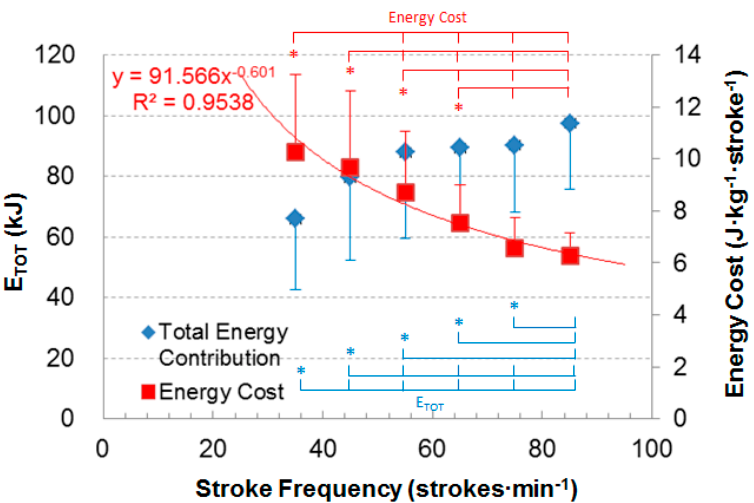
Figure 2. Total energy contribution and energy cost of the forehand loop drive at different stroke frequencies. Note: E TOT —total energy contribution. Y = 91.566 · x − 0.601 —the function of power